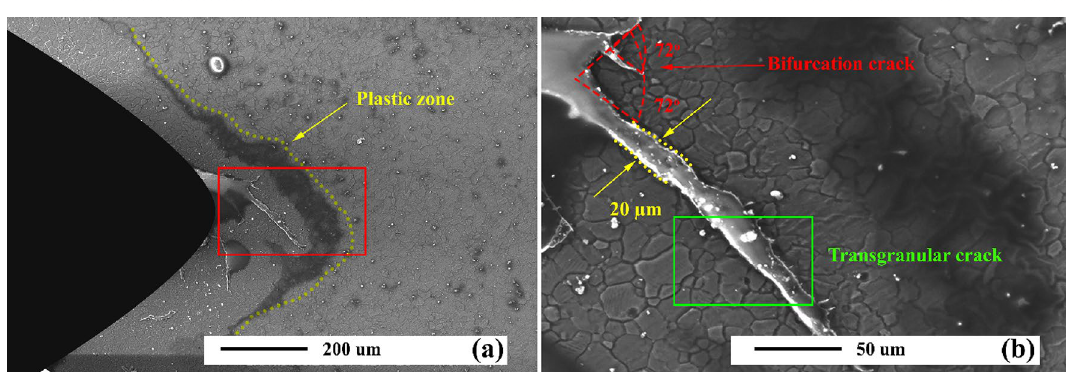
Figure 18. ( a ) SEM micrograph of aged unreinforced alloy after thermal cycles at 150 °C, and ( b ) higher